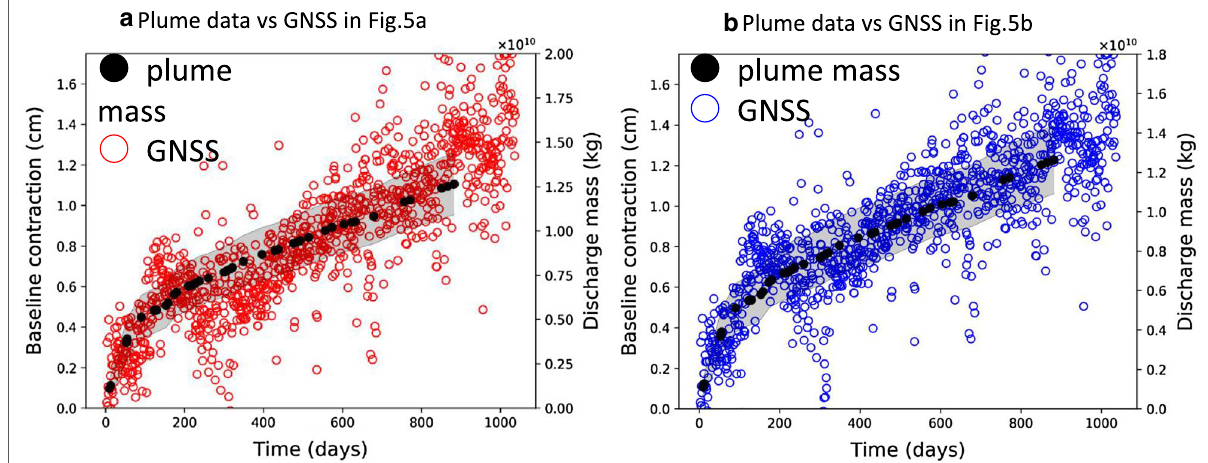
Fig. 6 Comparison between the discharge mass and the baseline contraction in Fig. 5 a ( a ) and Fig. 5b ( b ), respectively. Gray-shaded areas indicate range of estimated error of the discharge